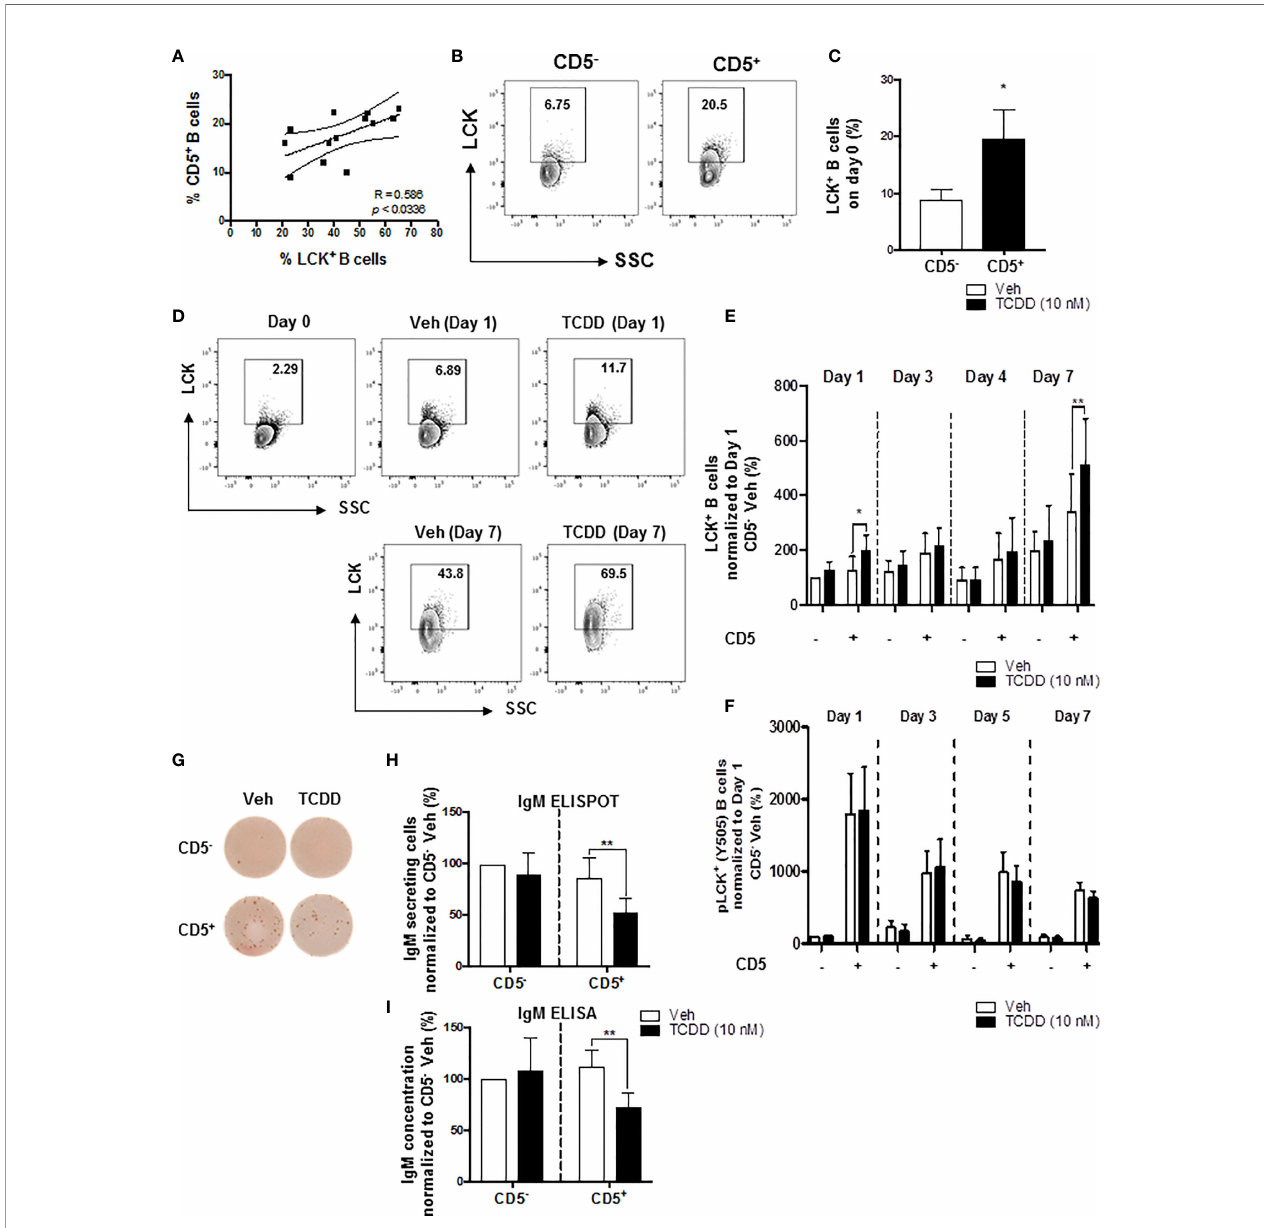
FIGURE 1 | TCDD-mediated increase in the percentage of LCK + human CD5 + ILBs and the suppression of the IgM response. Human CD5 +/- B cells were activated with CD40L, IL-21, and IL-2 and treated with Veh (0.02% DMSO), or TCDD (10 nM) on day 0 and cultured for 7 days. Cells and culture supernatants were collected and assessed for LCK and LCK Y505 phosphorylation by fl ow cytometry and IgM secretion via ELISA and ELIspot. (A) Correlation of percent CD5 + B cells and percent LCK + B cells; (B) Representative fl ow cytometry plots of CD5 + and LCK + cells; (C) Percentage of LCK + B cells within the CD5 +/- populations on day 0; (D) Representative fl ow cytometry plots of LCK + cells within CD5 +/- populations; (E) Percentage of LCK + B cells within CD5 +/- populations on day 1, 3, 4 and 7 with Veh or TCDD treatment; (F) Percentage of pLCK (Y505) + B cells within CD5 +/- populations on day 1, 3, 5 and 7 with Veh or TCDD treatment; (G) Representative ELIspot wells showing IgM secreting cells measured within CD5 +/- populations with Veh or TCDD (10 nM) treatment on day 7; (H) Number of IgM secreting cells; and (I) IgM concentration from culture supernatants from CD5 +/- B cells treated with Veh or TCDD. Determinations were made using B cells from 6 human donors (N = 6). For (E, F) , data were normalized to the CD5 - Veh on day 1. For (H, I) , data were normalized to CD5 - Veh. Signi fi cant differences are indicated by * p < 0.05 and ** p < 0.01 (Student ’ s T test or two-way ANOVA following with Fisher ’ s LSD post hoc